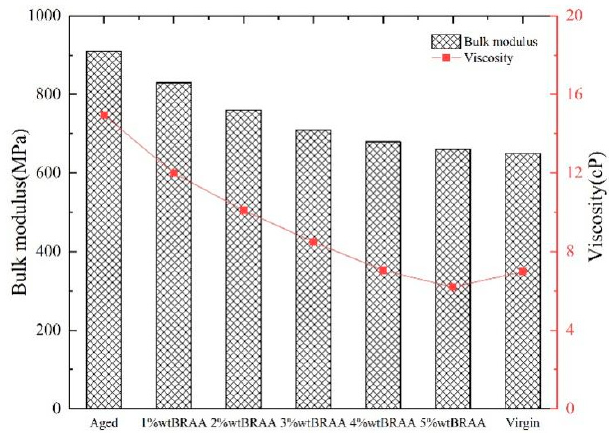
Figure 6. BRAA viscosity and bulk modulus results at 298.15 K.